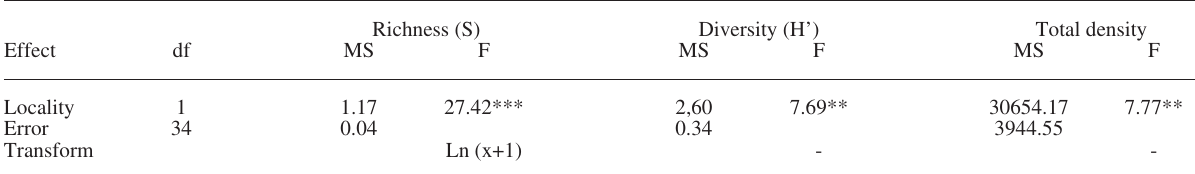
Table 2. – Results of ANOVA used to test for differences in the fish assemblage parameters and total density between the artificial reefs of Capo S. Marco (CSM-AR) and Torre Verdura (TV-AR). ** P<0.01; *** P<0.001.